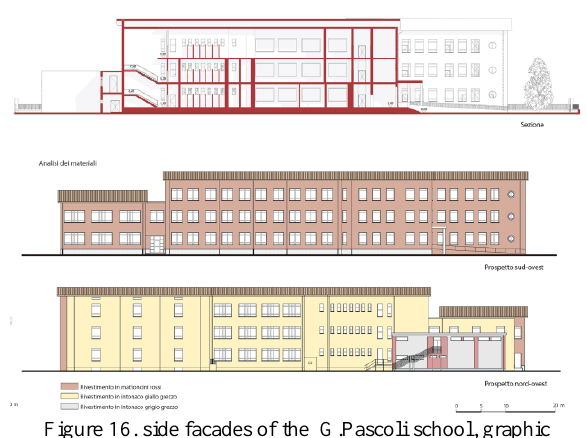
Figure 16. side facades of the G.Pascoli school, graphic representation of the materials in their current state.